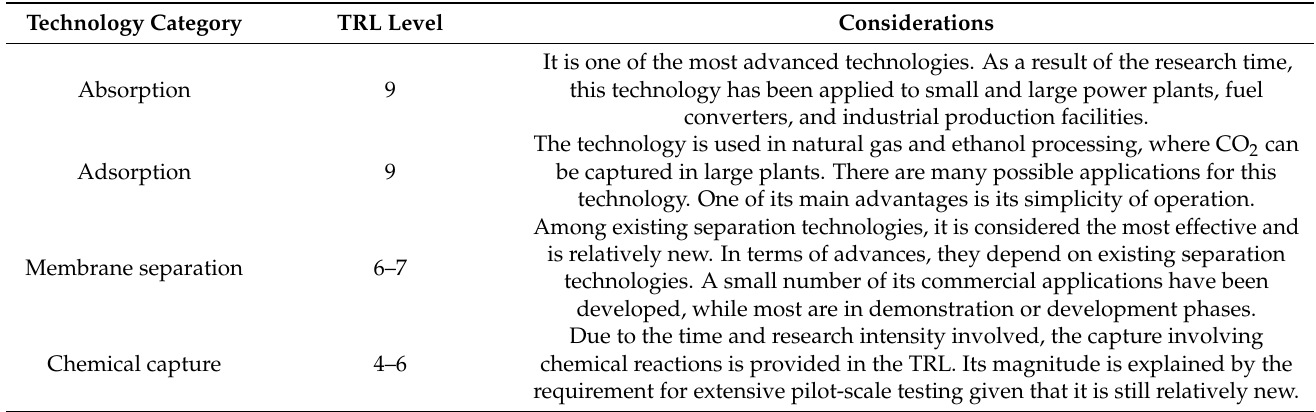
Table 12. TRL assessments for adsorption, absorption, membrane separation, and chemical capture technologies (2020) conducted by the International Energy Agency (2020)